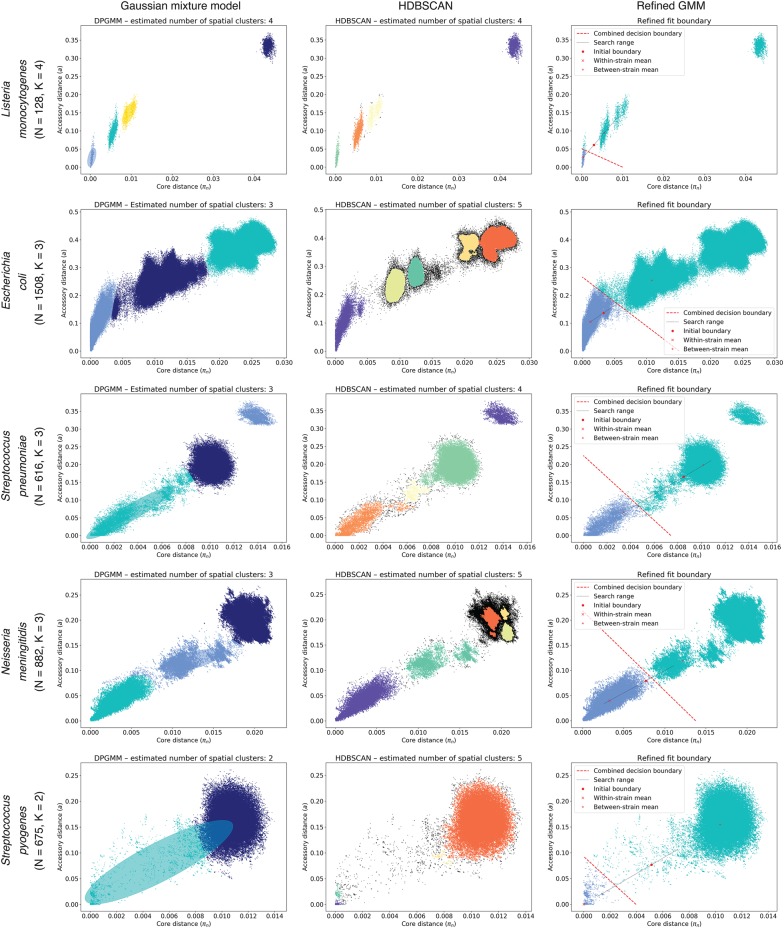
PopPUNK model fitting output for five archetypal examples (other species shown in Supplemental Fig. S8). Each row is a species, with each plot showing the distribution of core and accessory distances. In each plot, points are colored by their predicted cluster, and the cluster closest to the origin is the within-strain cluster. The two-dimensional Gaussian mixture model (2D GMM) is in the left column, which also shows ellipses with the mean and covariance of the fitted mixture components. The HDBSCAN plot in the center column shows unclassified noise points in black. The right column shows the fits when maximizing the network score to refine the 2D GMM fit. Listeria monocytogenes has clearly separated clusters, which were well-predicted by all methods. Although there is more complex structure on the plots, Escherichia coli and Neisseria meningitidis have a within-strain cluster also well captured by all approaches. In Streptococcus pneumoniae, recombination makes the boundary between clusters less distinct, and the mixture model includes too many links (Fig. 5A). HDBSCAN is more accurate, but the refinement of the initial fit provides the most accurate and intuitive demarcation of the within-strain links. Streptococcus pyogenes exhibits low within-strain recombination; hence, it has a dense cluster of points near the origin of the graph, but high between-strain divergence, resulting in the single, broad between-strain set of points. Network score fit refinement is required for an accurate model fit in this case.